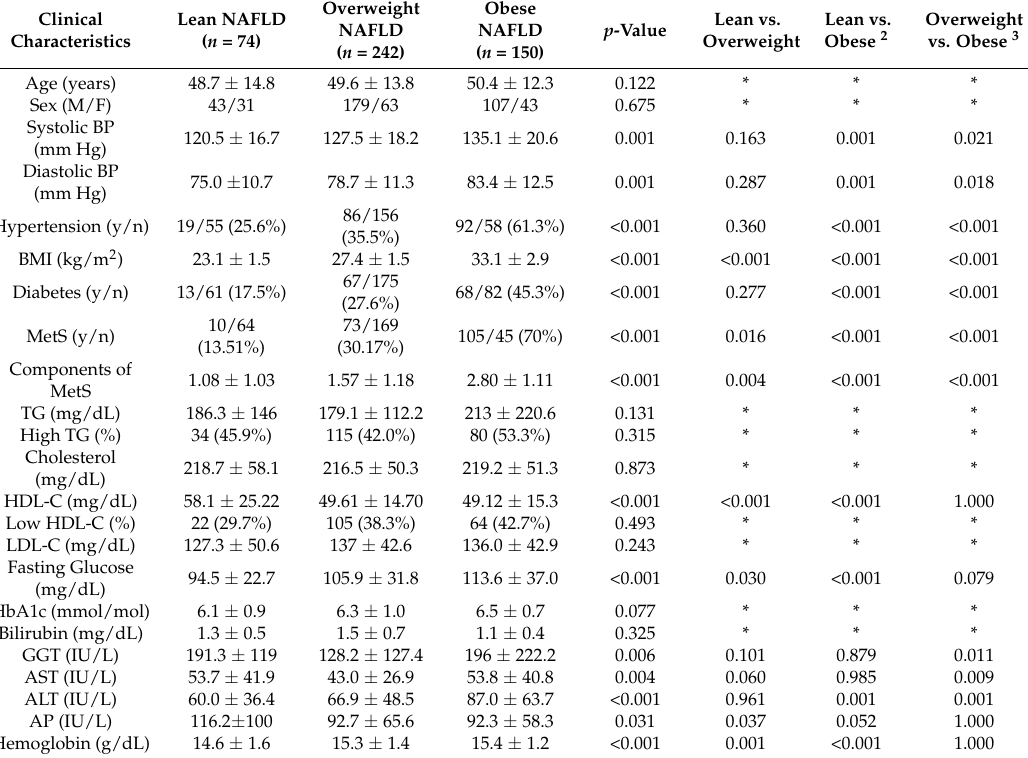
Table 1. Clinical, anthropometrical and biochemical characteristics of the study population. Clinical